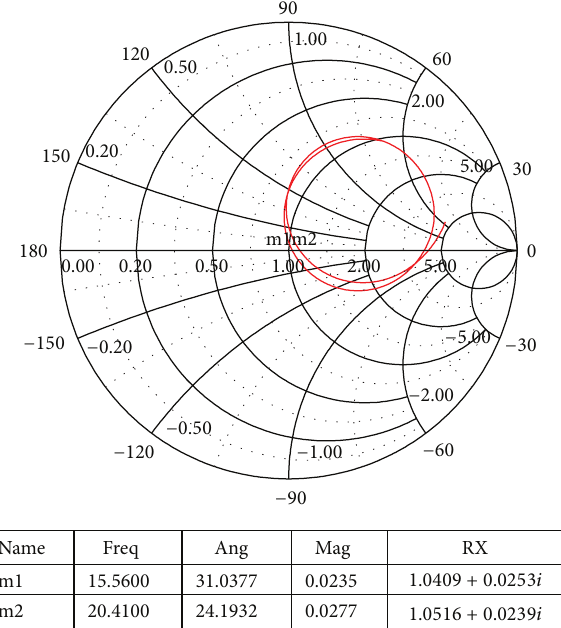
Figure 17: The Smith chart of the proposed